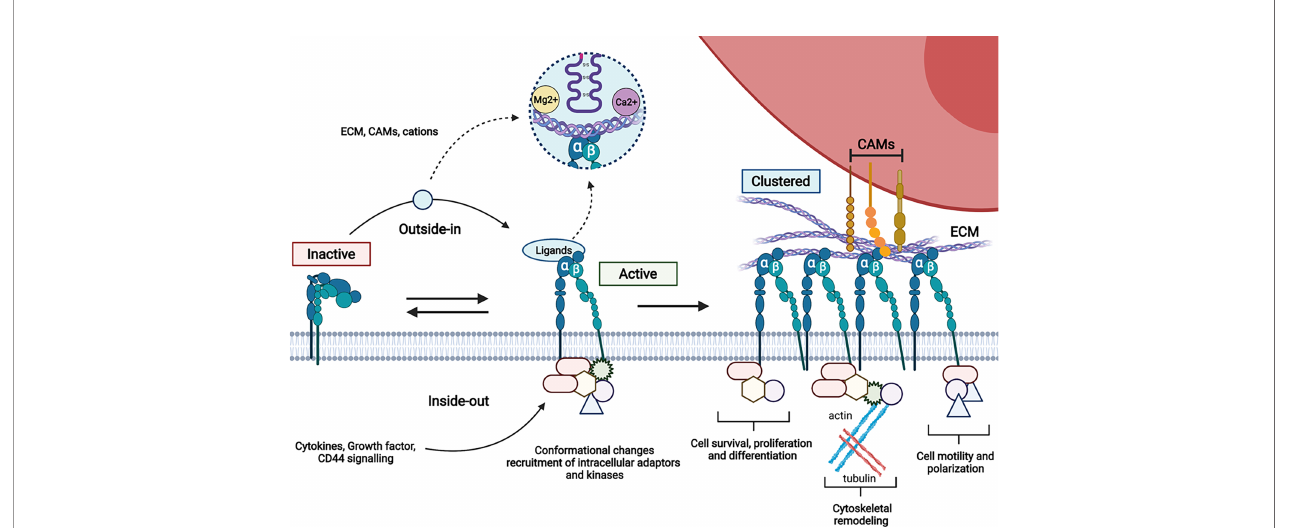
FIGURE 2 | Schematic representation of integrin activation. The variety of intracellular protein complexes involved in integrin signalling (kinases, adaptors … ) is depicted by forms recruited to the cytoplasmic tails of